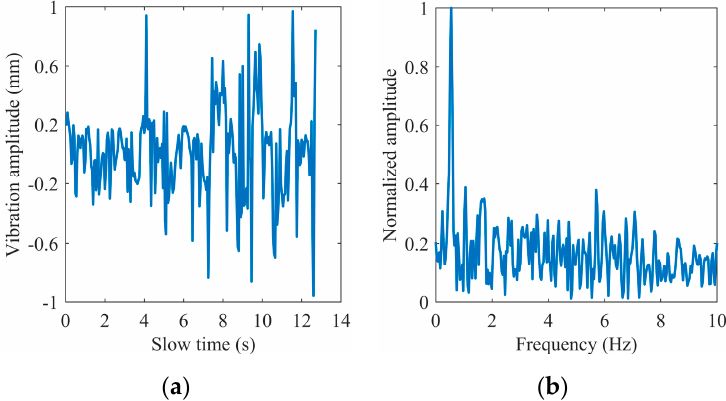
Figure 4. Extracted phase by the extended DACM: ( a ) in the time domain; ( b ) in the frequency do- main.